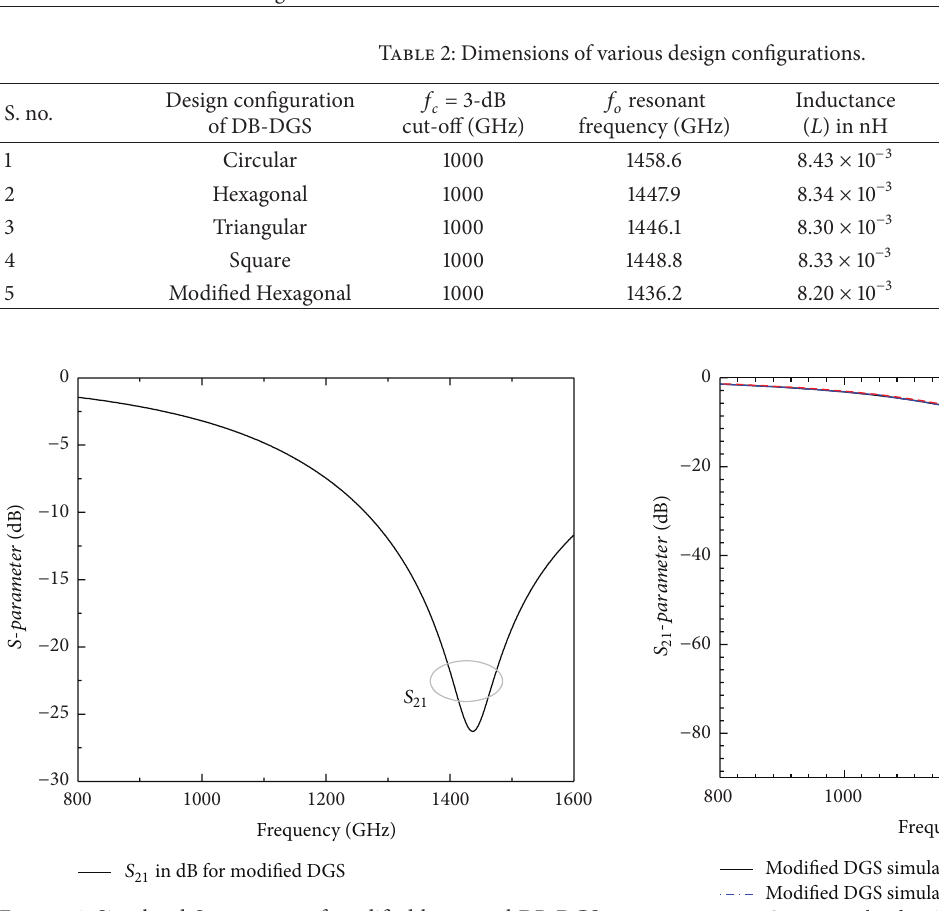
Figure 4: Simulated S-parameter of modified hexagonal DB-DGS [22].